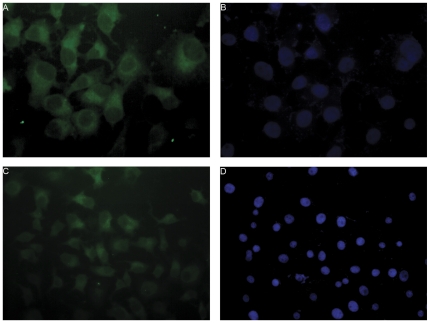
The expression of EGF protein in BxPC-3 and Panc-1 cells.Cells were labeled with fluorescence-conjugated EGF specific antibody (green) in both BxPC-3 (Fig. 2A, 2B) and Panc-1 cells (Fig. 2C, 2D) (200×). Granules with green fluorescence are apparent in cell plasma but not in the nucleus in both BxPC-3 and Panc-1 cells (Fig. 2A and Fig. 2C). Fig. 2B and Fig. 2D were the nucleus staining with DAPI.